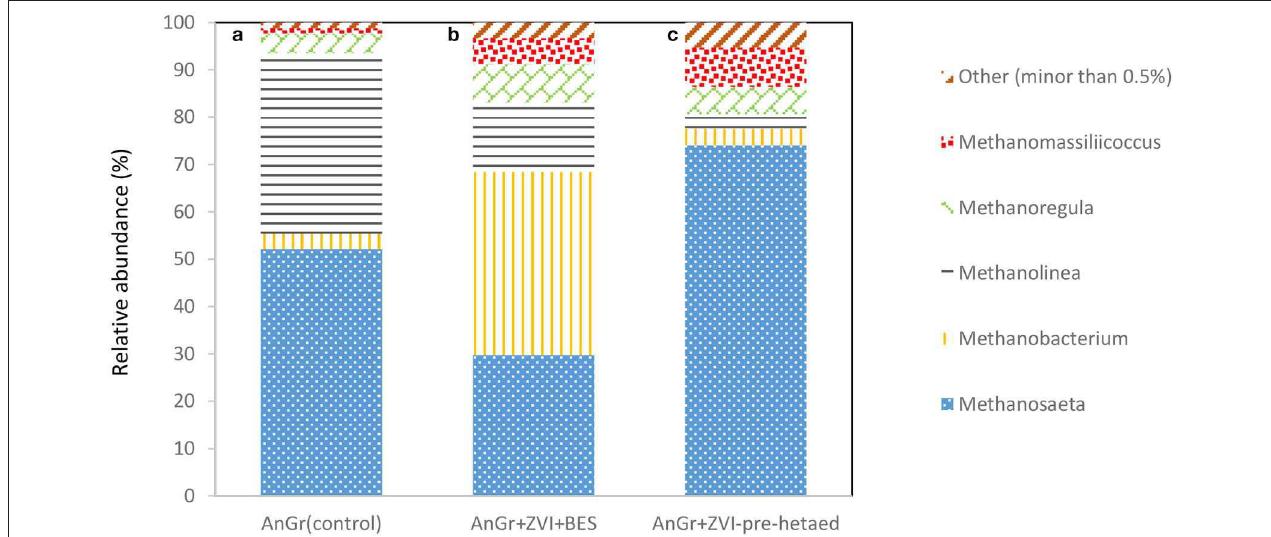
FIGURE 13 | XRD data from the surfaces of (A) ZVI (black line), (B) ZVI after 27 days exposure to anaerobic granular sludge, BES and CO 2 (red line), and (C) ZVI after exposure for 24 days to 60g NaCl/L anaerobic granular sludge and CO 2 (green line).